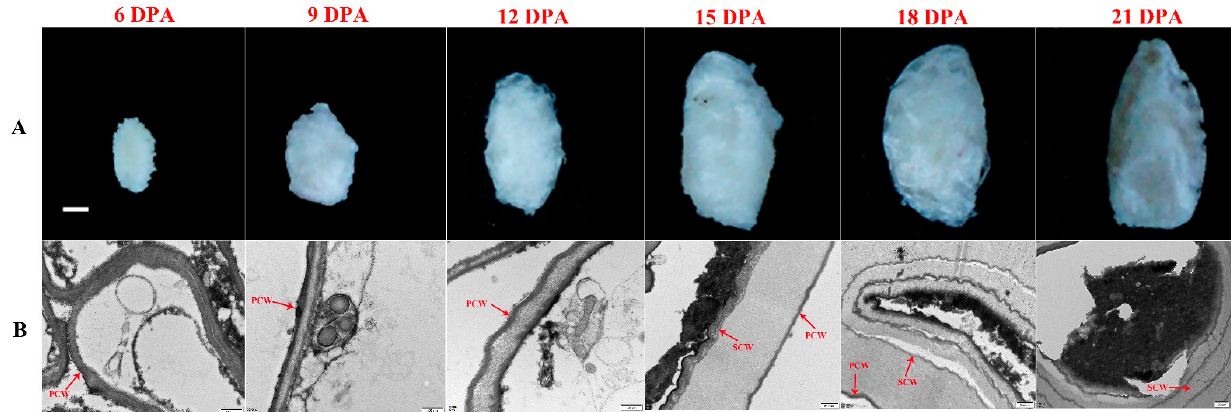
Figure 1. Fiber development in Gossypium stocksii . ( A ) Morphology and coloration of the developing fibers. Scale bar: 1 mm. ( B ) Microstructures of the developing fibers. Apparent secondary cell wall was observed at 18 DPA. PCW: primary cell wall; SCW: secondary cell wall. scale bar: 500 nm. Toluidine blue O (TBO) staining was used to assay the accumulation of PAs in developing G. stocksii fibers. We found that TBO stained dots scattered in the fibers at 6 and 9 DPA, indicating that the PAs had been synthesized and deposited then. At 15 and 18 DPA, the stained patches were increased in the fibers but significantly reduced at 21 DPA. This suggests that the PA synthesis was maintained at a high level during the stages of G. stocksii fiber elongation and early SCW biosynthesis, but was significantly reduced when SCW thickened (Figure 2).